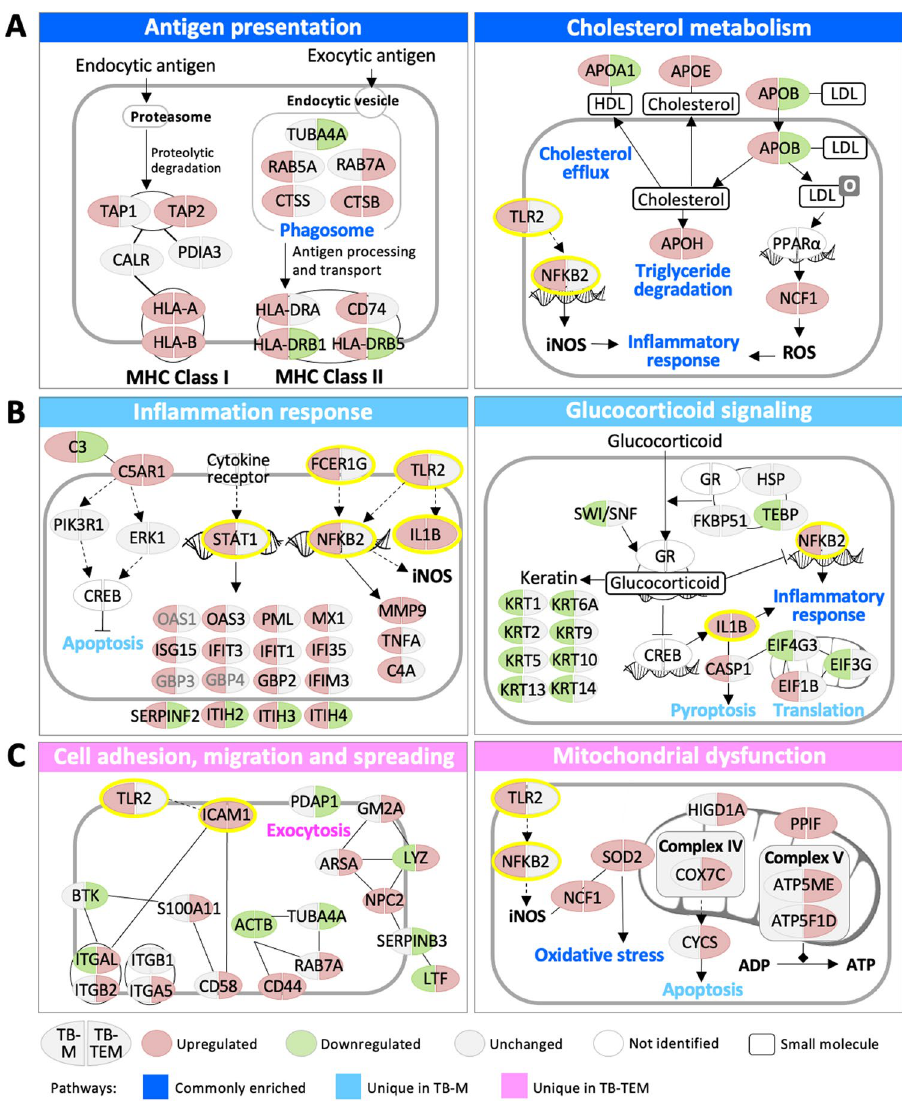
Figure 3. Unique and commonly dysregulated mechanisms in the heat-killed tuberculosis (HKTB)-stimulated classically activated macrophage (TB-M) and HKTB-stimulated tumor-educated macrophage (TB-TEM) models. ( A ) Commonly enriched mechanisms in both the TB-M and TB-TEM models. ( B ) Uniquely enriched mechanisms in TB-Ms. ( C ) Uniquely enriched mechanisms in TB-TEMs. Proteins with grey gene names were identified in a single-batch of experiments